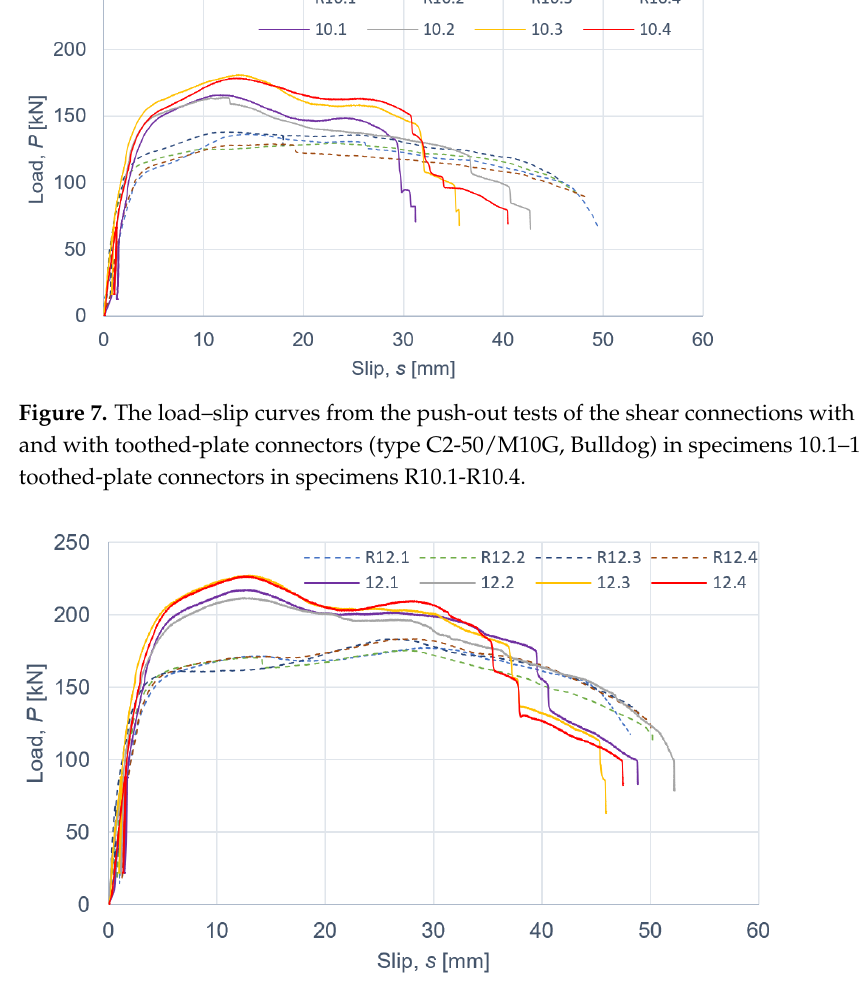
Figure 8. The load–slip curves from the push-out tests of the shear connections with 12 mm screws and with toothed-plate connectors (type C2-50/M12G, Bulldog) in specimens 12.1–12.4 or without toothed-plate connectors in specimens R12.1-R12.4.